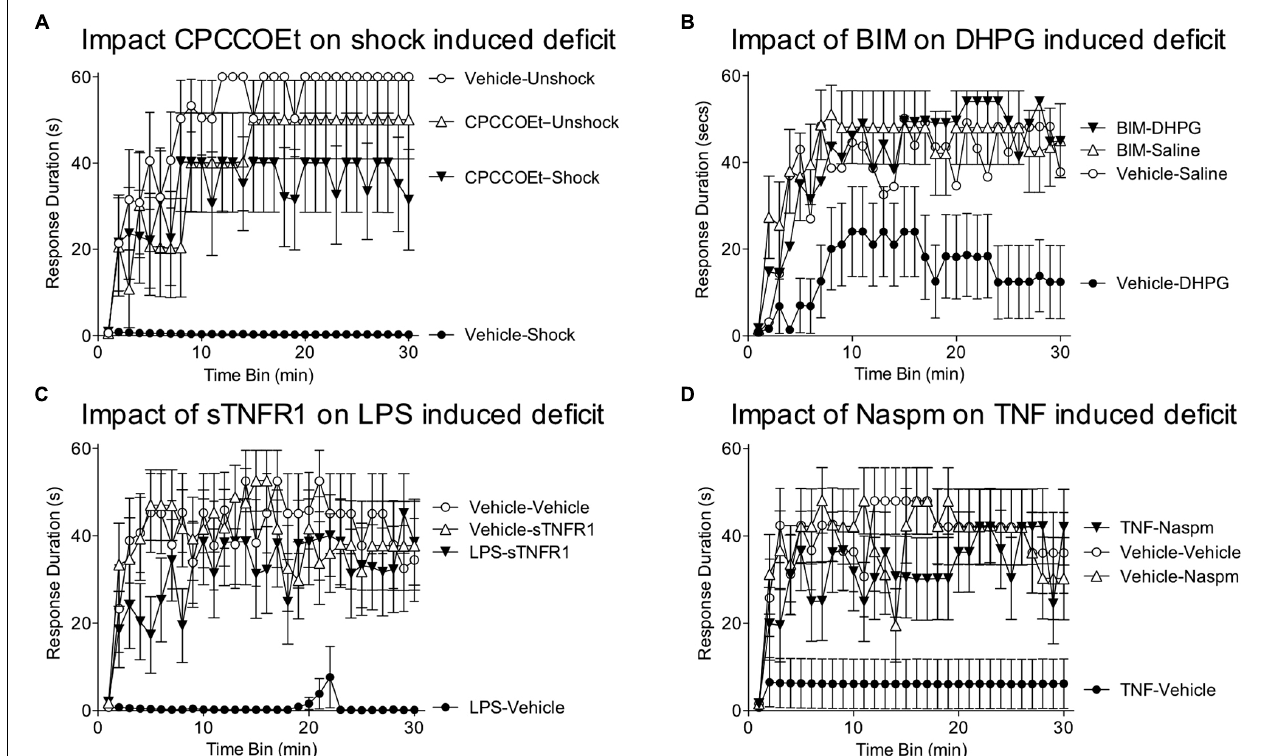
FIGURE 5 | Role of group 1 mGluR, glia, andTNF in the learning deficit. (A) Spinally transected rats received the group 1 mGluR1 antagonist CPCCOEt (i.t.; 100 nmol), or its vehicle, prior toVIS (Shock). Instrumental learning was tested 24 h later. Prior exposure to shock inhibited learning (Vehicle-Shock). Pretreatment with CPCCOEt blocked the induction of this learning impairment (CPCCOEt-Shock). (B) Rats were pretreated with the PKC inhibitor BIM (i.t.; 0.023 nmol), or its vehicle, and then received an injection of the group 1 mGluR agonist DHPG (100 nmol) or saline. Administration of DHPG alone (Vehicle-DHPG) impaired learning and this effect was blocked by pretreatment with BIM (BIM-DHPG). (C) Subjects